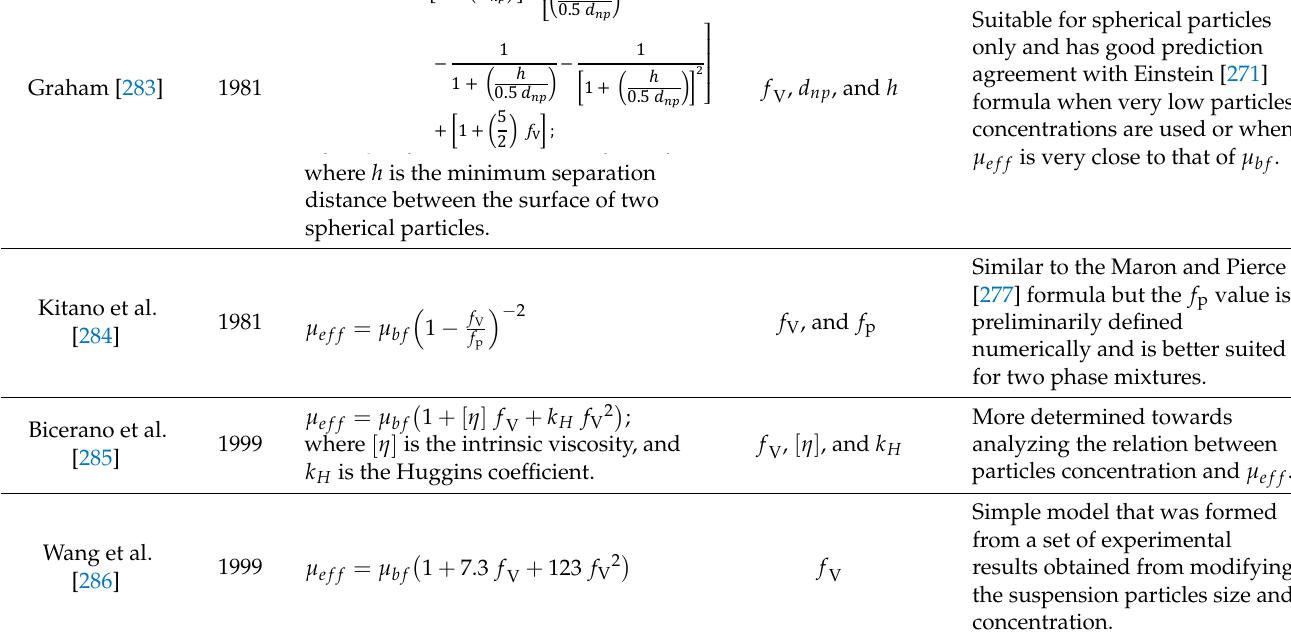
Employed for uniform spherical particles and assumes concentration is due to their hydrodynamic